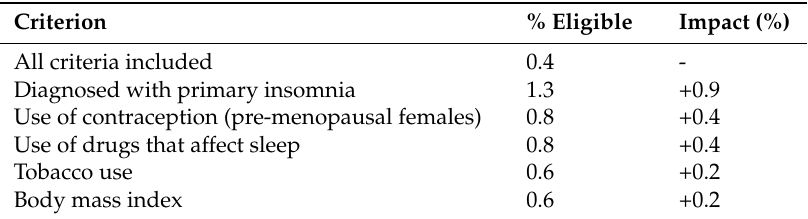
Table 4. Percentage of eligible patients when a specific criterion was not applied.